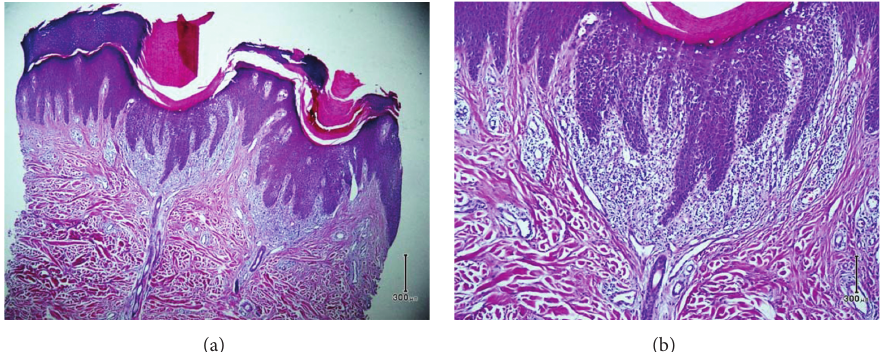
Figure 2: Small epidermal invagination with overlying parakeratotic cornoid lamellation and underlying, slightly tortuous, eccrine duct nearby the epidermis. Loss of granular layer and few dyskeratotic cells were evident at the base of epidermal invagination (Figure 2(a), H&E ×100 ), (Figure 2(b), H&E ×400